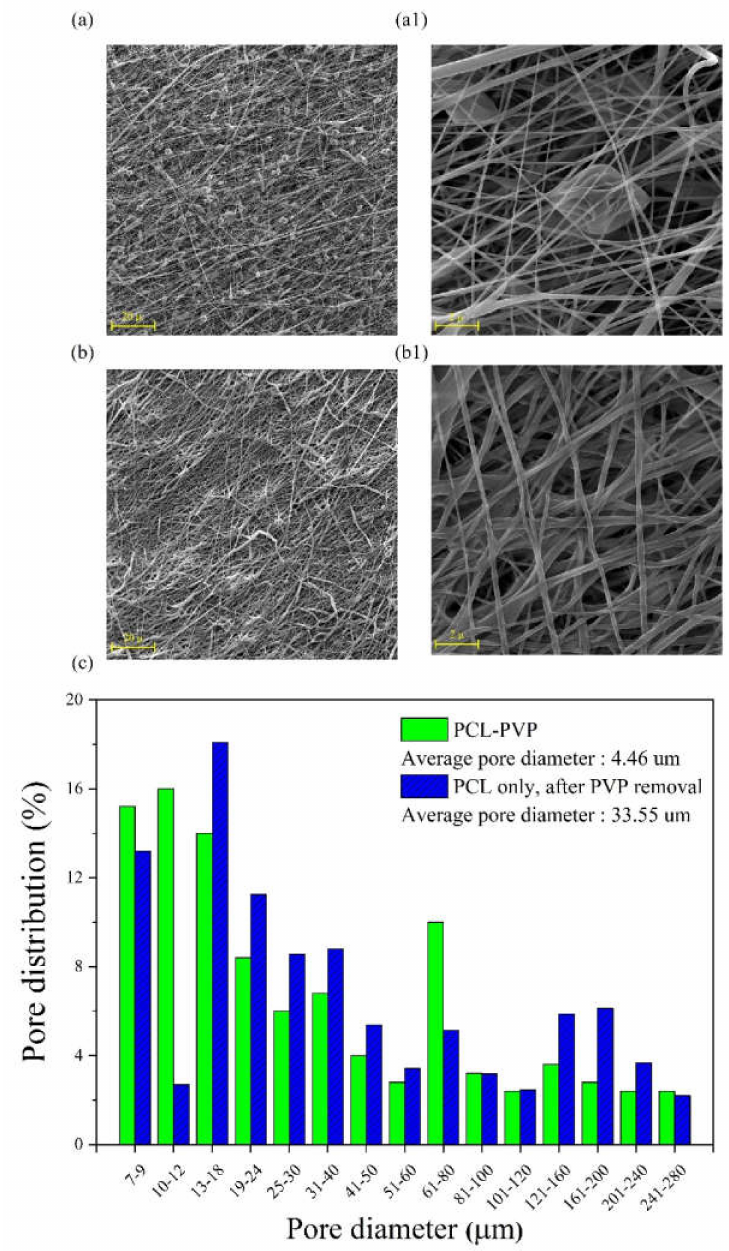
Figure 3. SEM images of PCL fibrous mats after the soaking of simultaneous electrospun PCL / PVP samples in water for 24 h: ( a,a1 ) before immersion; ( b,b1 ) after immersion; ( c ) comparative histograms for pore diameter distribution before (PCL-PVP)and after (PCL) immersion in